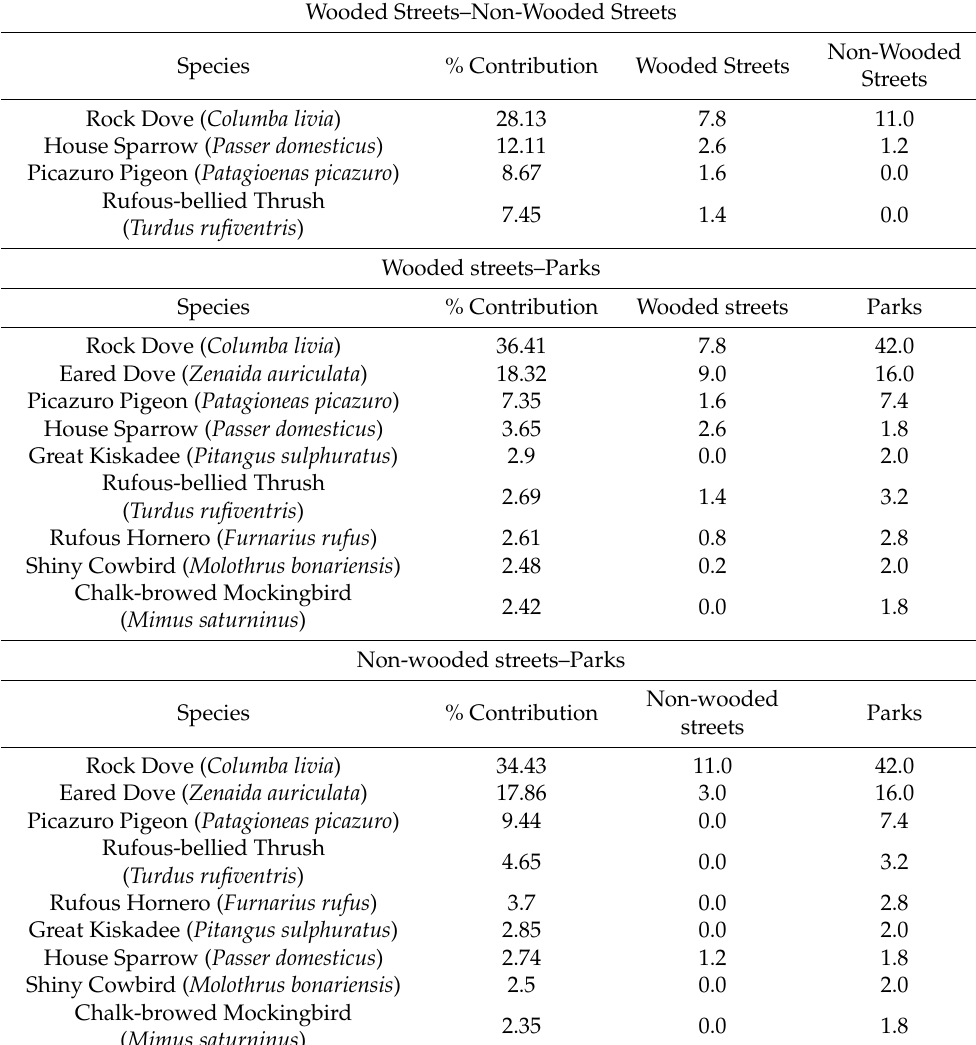
Table 2. Similarity percentage analysis (simper) between habitat types, showing the species per- centage contribution to the dissimilarity of species composition (% contribution), and the average abundance of those species with a large contribution to dissimilarity (see